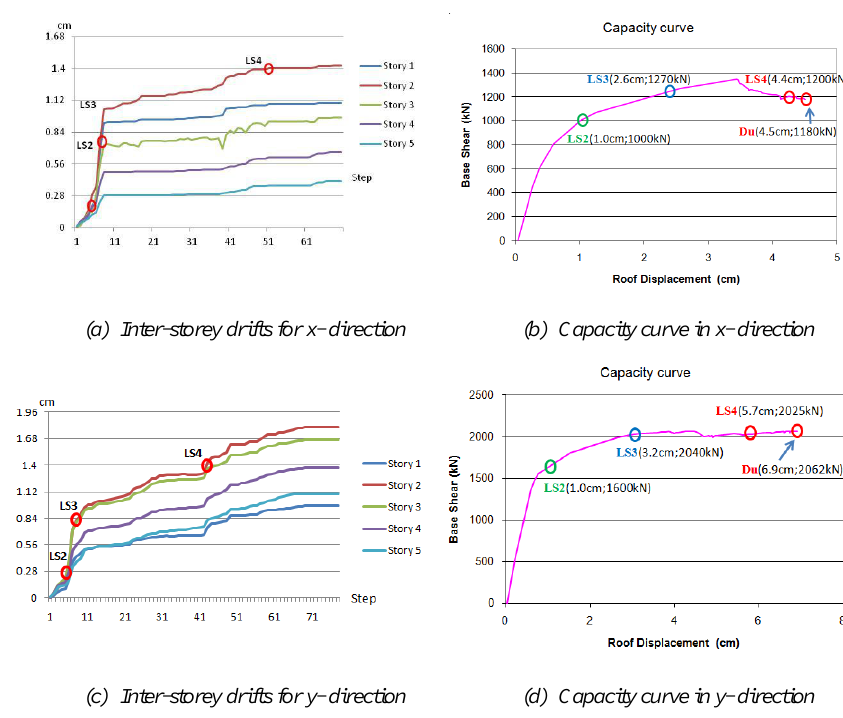
Fig. 10. Inter-storey drift ratios and capacity curve representation of the TD-72/1 obtained by pushover analysis